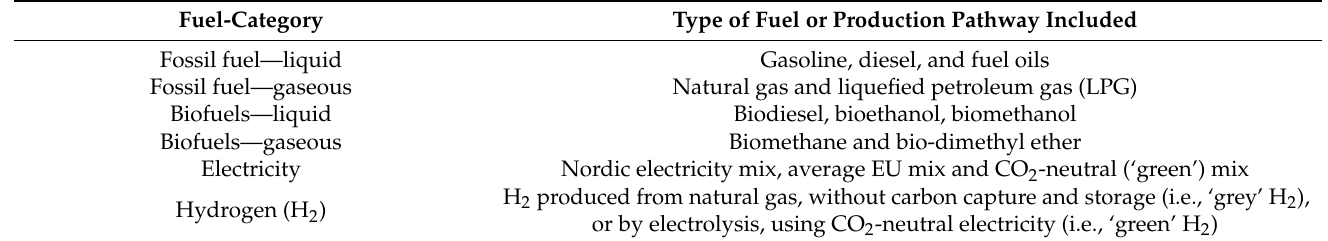
Table 5. Aggregate